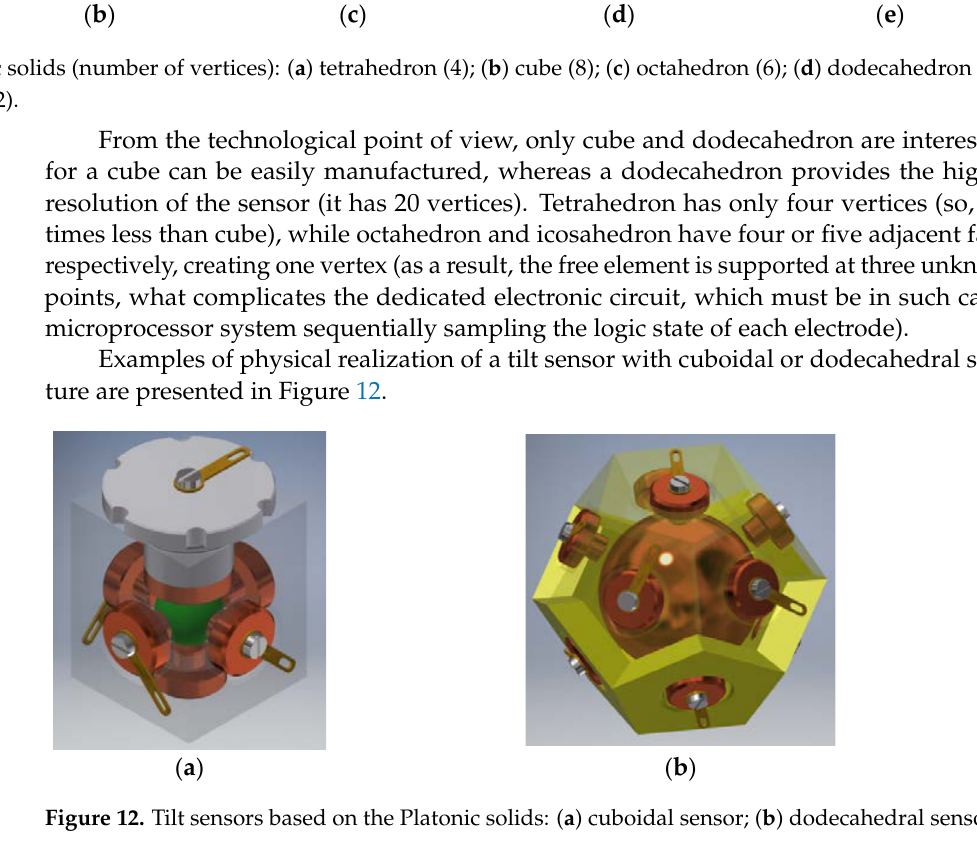
Figure 11. The Platonic solids (number of vertices): ( a ) tetrahedron (4); ( b ) cube (8); ( c ) octahedron (6); ( d ) dodecahedron (20); ( e ) icosahedron (12).